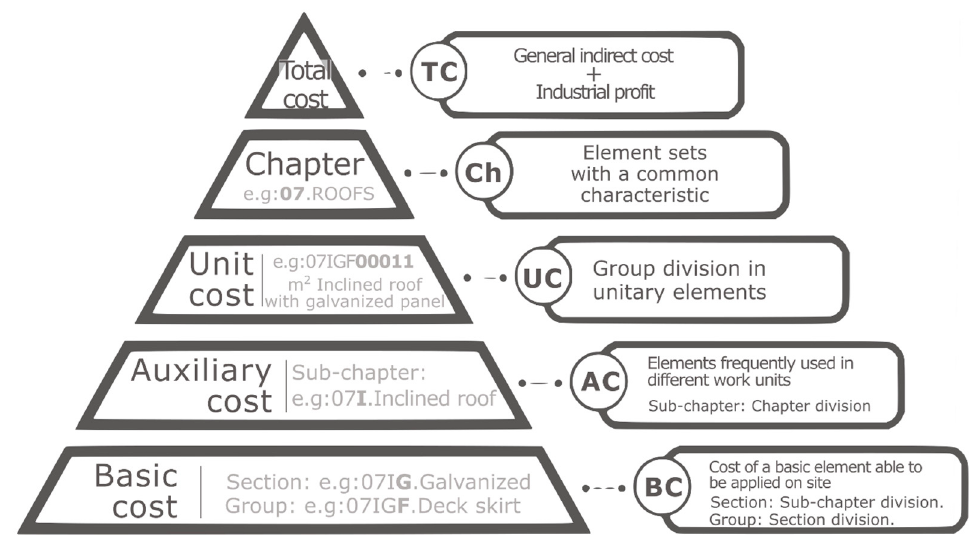
Figure 2. Hierarchical pyramid of the ACCD (adapted from [42]).